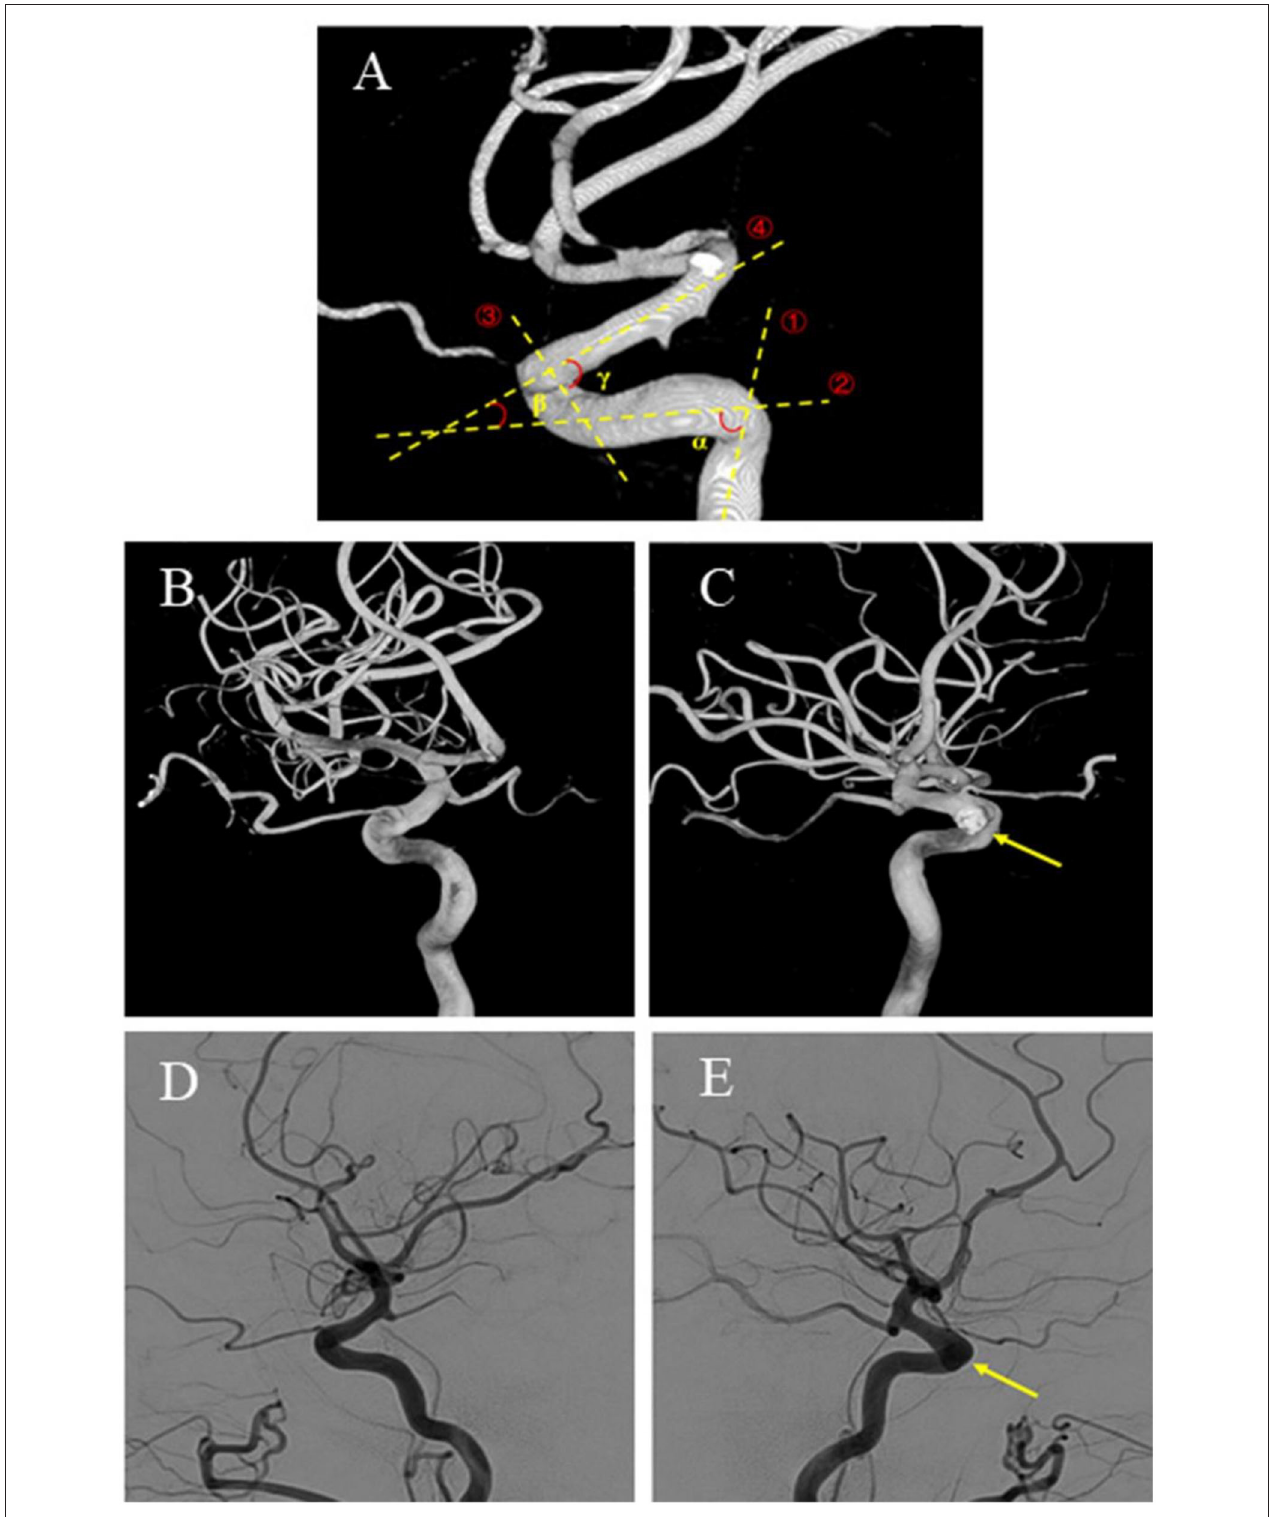
FIGURE 3 | Angle measurement in a patient with unilateral carotid siphon aneurysms. (A) ‹ , Passes through the centerline of the vertical cavernous segment vessel. › , Passes through the centerline of the horizontal cavernous segment vessel. fi , Passes through the centerline of the clinoid segment vessel. fl , Passes through the centerline of the ophthalmic segment vessel. α , Carotid siphon posterior bend angle. β , Carotid siphon anterior bend angle. γ , Carotid siphon Clinoid@Ophthalmic bend angle. Images (B–E) from the same patient. (B,C) Volume rendering image of bilateral three-dimensional rotational angiography data of a patient with unilateral paraclinoid aneurysm. (C) The aneurysmal side (yellow arrow). (D) DSA of the unaffected contralateral side. (E) DSA of the aneurysmal side (yellow arrow). 3D-DSA: three-dimensional digital subtraction angiography. Frontiers in Neurology | www.frontiersin.org 5 May 2022 | Volume 13 | Article